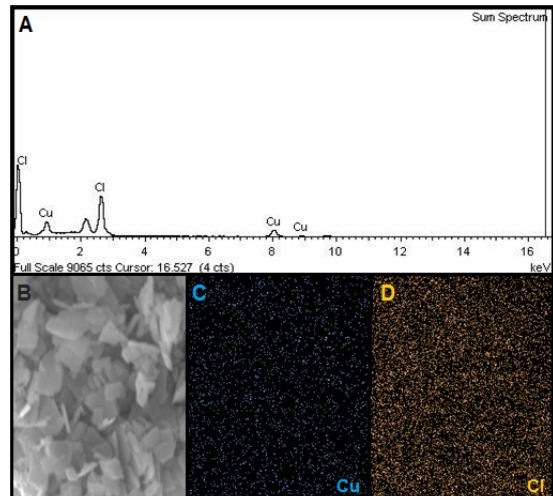
Fig. 3. EDX spectra of Cu nanocomplex